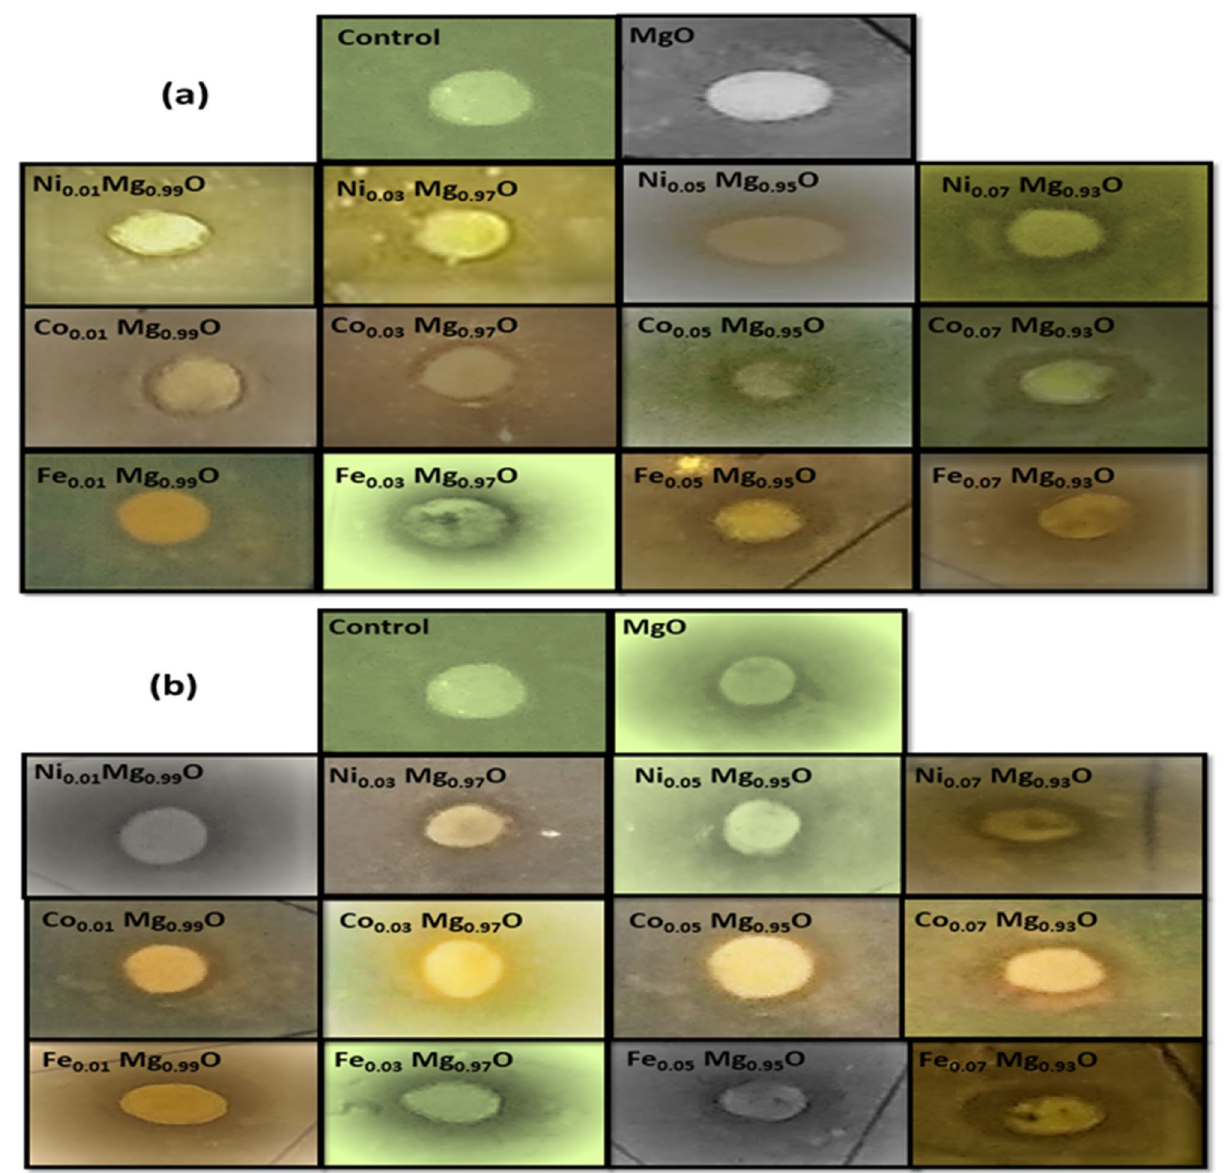
Figure 16. Appearances of the zone of inhibition for ( a ) 40 μg/ml of Ni, Co, and Fe-doped MgO nanoparticles. ( b ) 80 μg/ml of Ni, Co, and Fe-doped MgO nanoparticles with S.